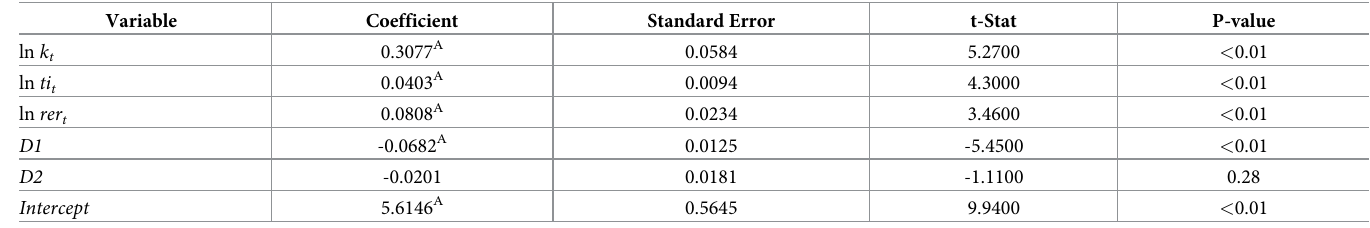
Table 10. PCA ridge estimates.